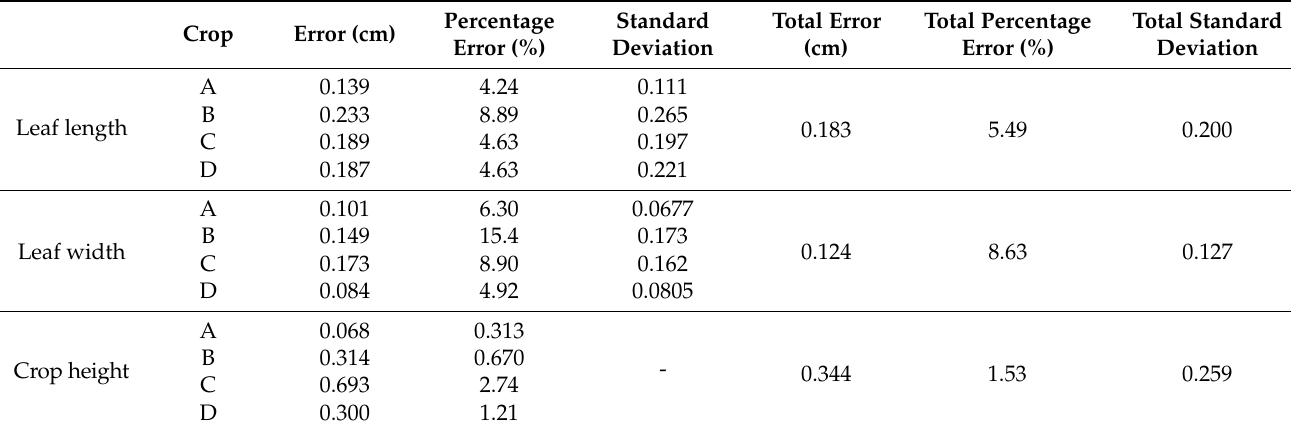
Table 3. Absolute error, percentage error, and standard deviation between the ground-truth data and the measured values in 3D reconstruction models.